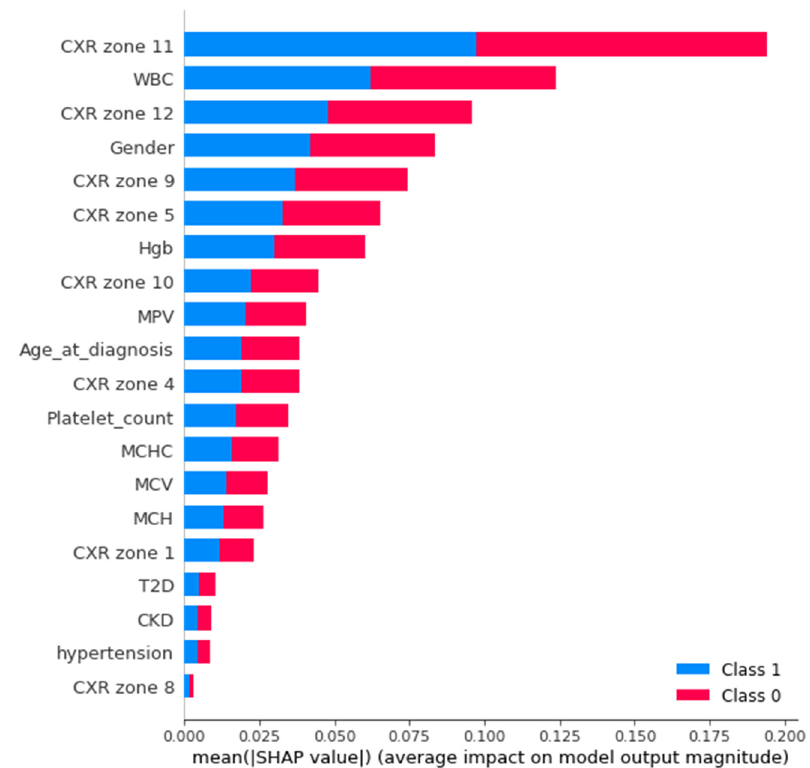
Figure 10. Mean (SHAP value) for the prediction of ventilatory support patients (Case 3).